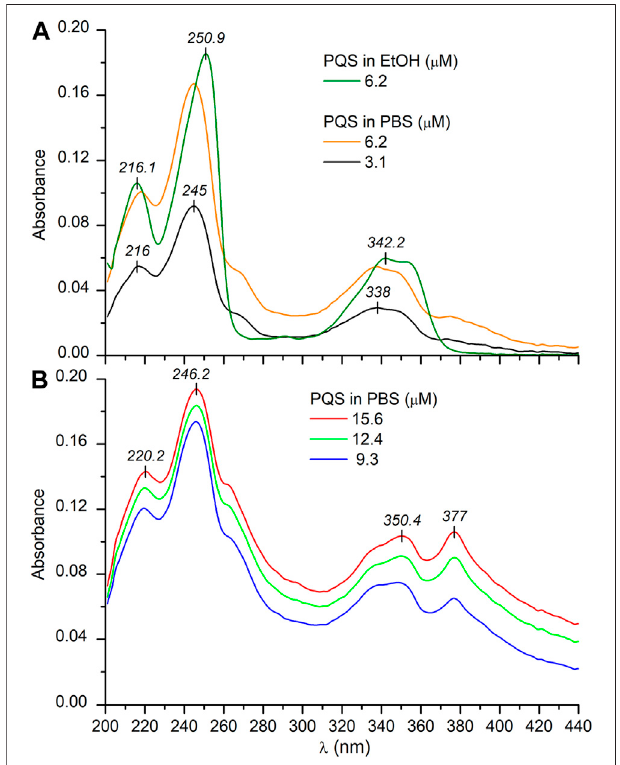
FIGURE 1 | UV/VIS absorption spectra of PQS recorded in PBS at low (A) andathigher (B) concentrations.TheabsorptioncurveobtainedinEtOHis also shown (A) . The optical path length is 1